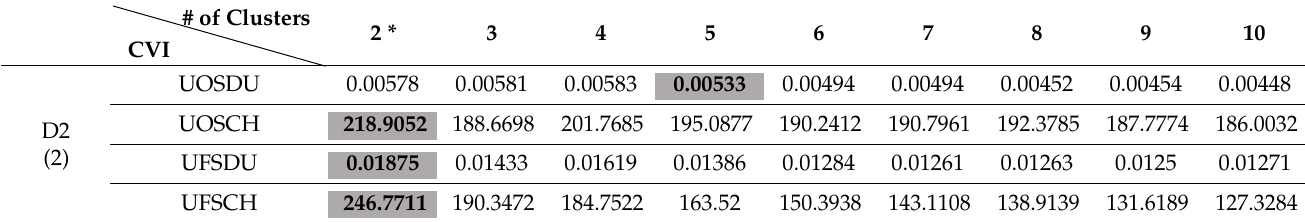
Table 3. Performance results for D2.